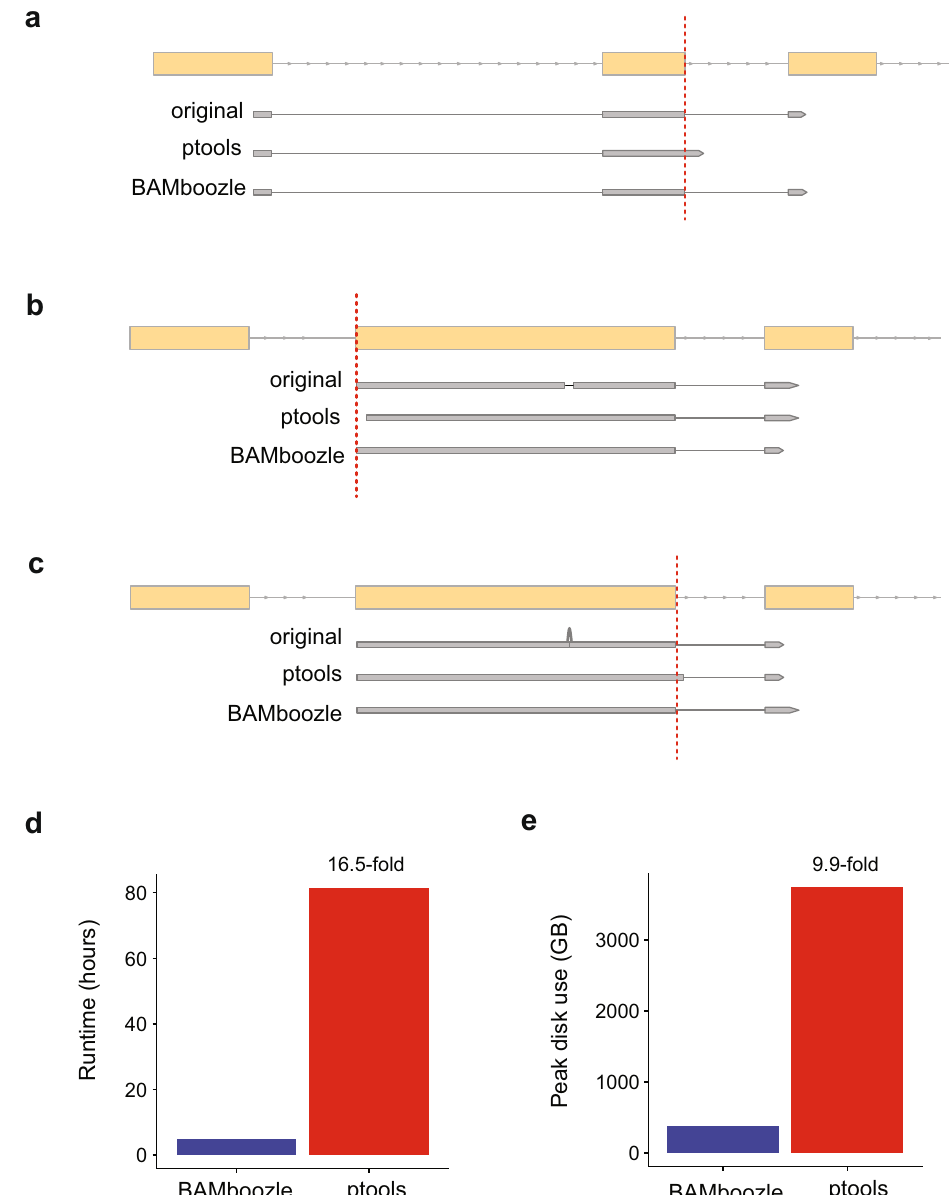
Fig. 5 Comparison between BAMboozle and ptools . a – c Spliced alignments with avoidable information loss during processing in ptools . Yellow boxes denote exons for gene models. Exemplary reads (original and processed by ptools or BAMboozle ) are shown as gray boxes. Reference skip ( N ) for spliced alignments is denoted by gray lines. a Alignment covering several splice junctions is correctly reported by BAMboozle while ptools reports only the fi rst splice site. b Spliced alignment with deletion. Information loss in BAMboozle is avoided by keeping 5 ’ mapping position and splice junction intact. c Insertion in a spliced alignment is resolved while keeping splice junction intact in BAMboozle . d , e Benchmarking of ptools and BAMboozle on 2.42 billion PE150 reads shows that run time for BAMboozle is d 16.5-fold faster (4h 57min vs 81h 31min) and e consumes 9.9-fold less storage space (378.5GB peak vs 3741.1GB